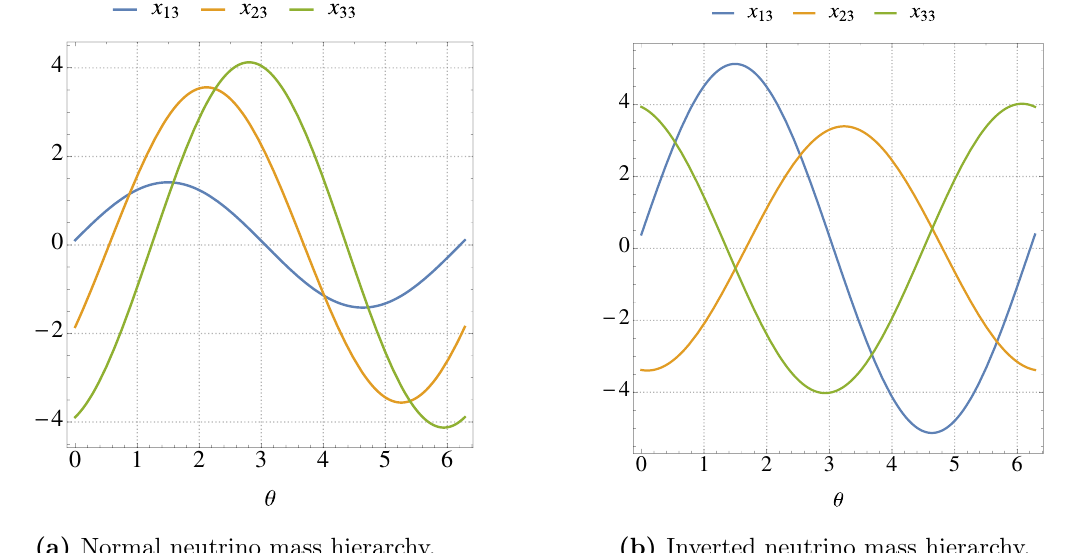
Figure 16. Plots of the relative sizes of the couplings of the leptoquark (cid:30) 1 to the bottom quark and the i th neutrino (cid:13)avor against (cid:18) , the Casas-Ibarra parameter, for m